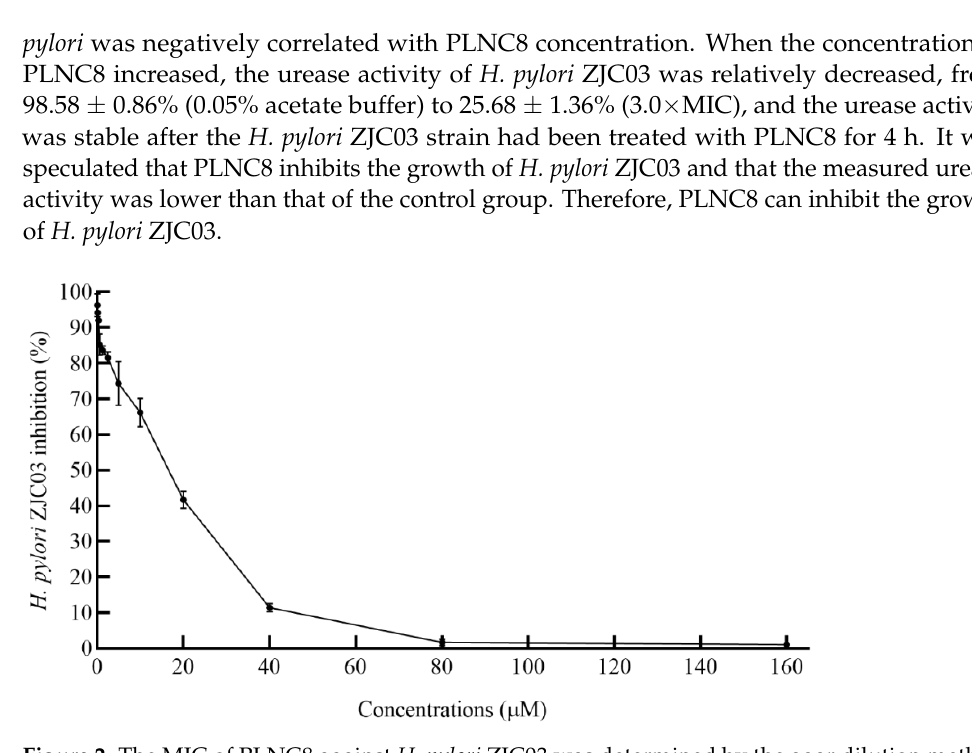
Figure 2. The MIC of PLNC8 against H. pylori ZJC03 was determined by the agar dilution method with a concentration range of 0–160 µ M obtained by the twofold dilution method. The plates with the H. pylori co-cultured PLNC8 mixture were incubated at 37 ◦ C in a microaerobic environment of 10% CO 2 , 10% O 2 , and 80% N 2 for 72 h. The plate bacteria were gently washed down, and the bacterial suspension absorbance was measured at 550 nm to calculate the antibacterial rate.